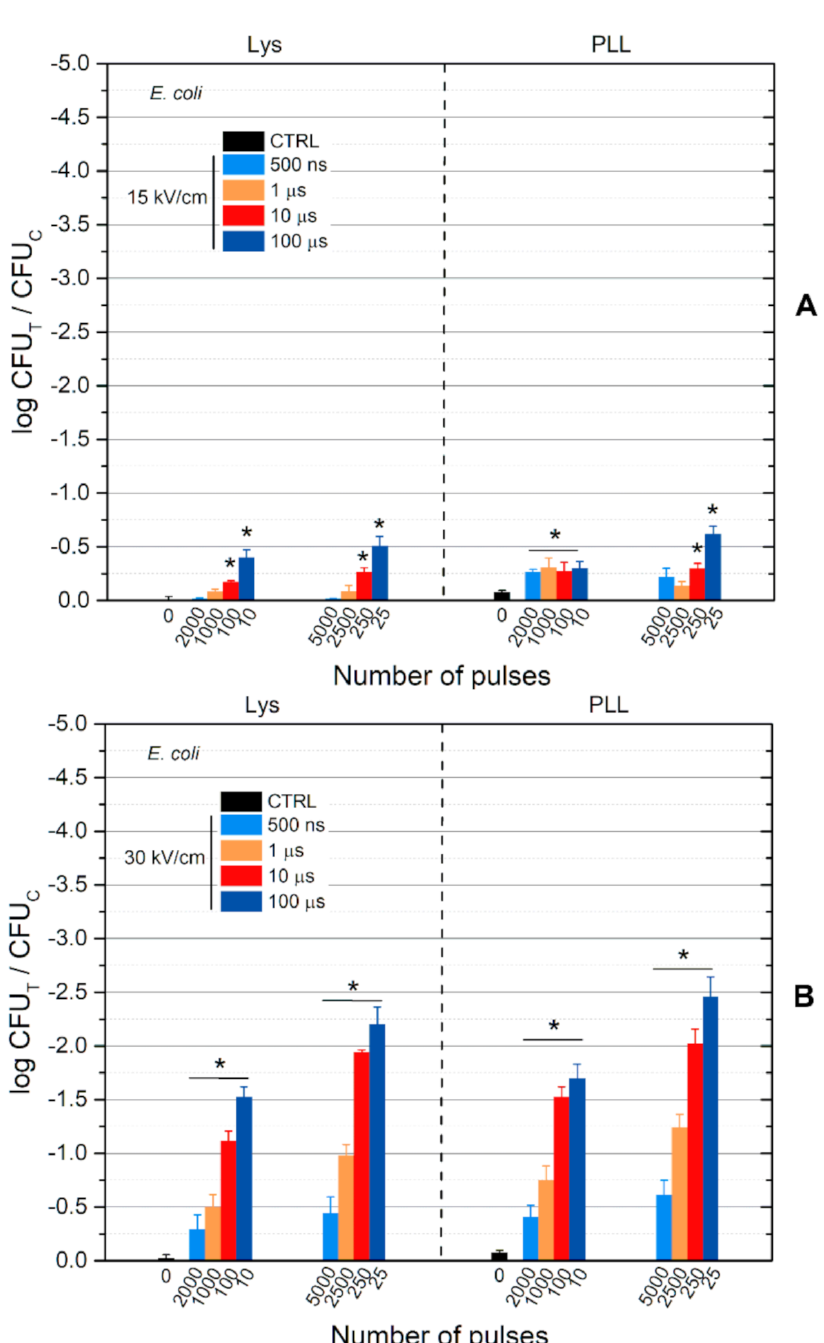
Figure 5. The antimicrobial efficacy of L-lysine and poly-L-lysine with pulsed electric field treatment against E. coli , where ( A ) 15 kV/cm treatment; ( B ) 30 kV/cm treatment. Asterisk (*) represents statistically significant ( p < 0.05) difference versus Lys or PLL treatment, respectively. CTRL—samples with Lys or PLL without PEF